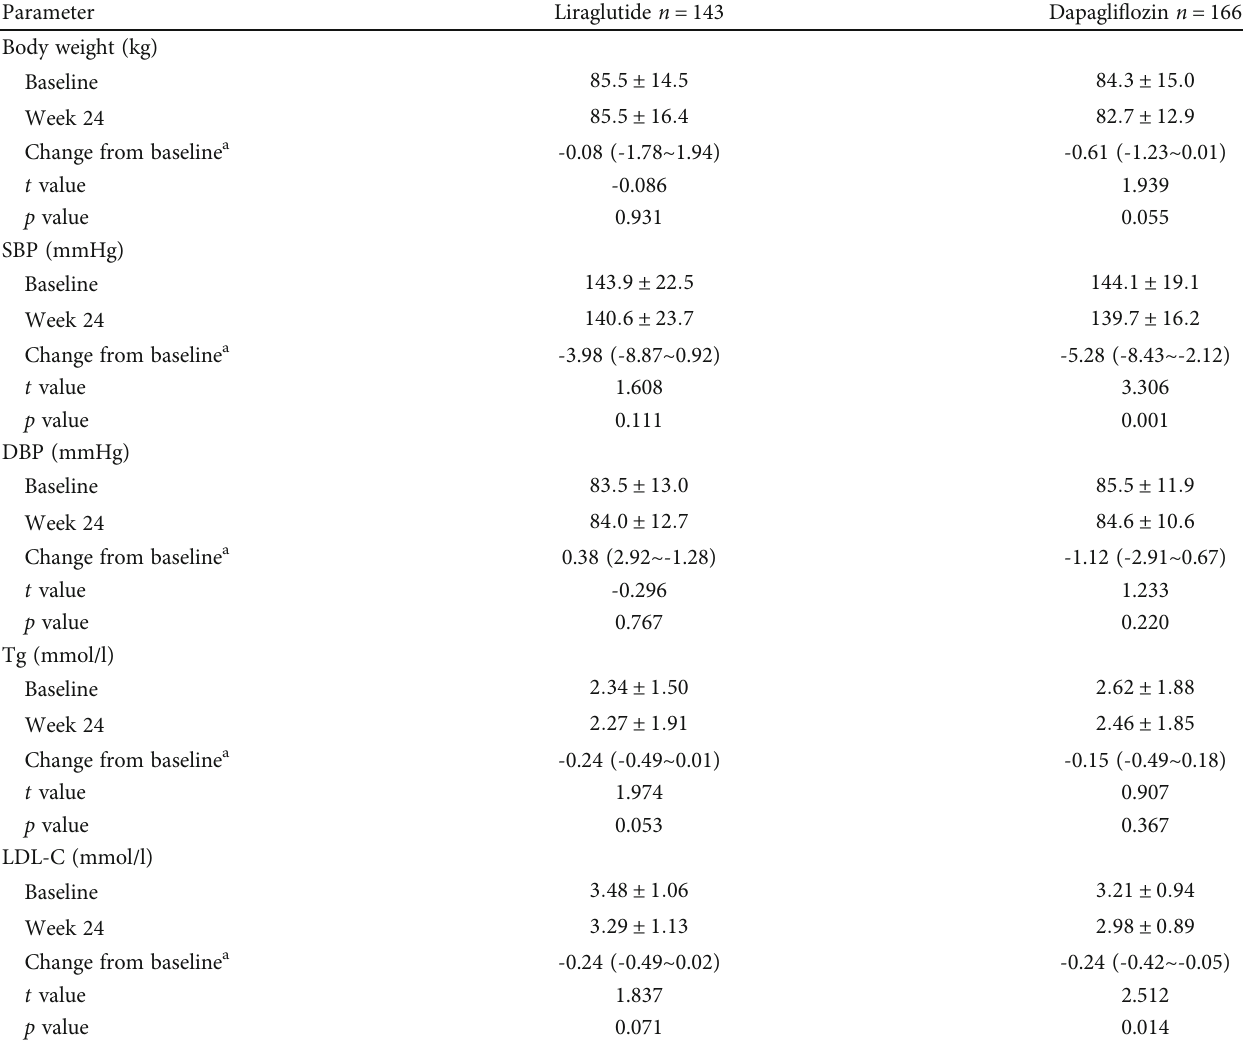
Table 3: Changes in other metabolic indicators (body weight, Tg, LDL-C, DBP, and SBP) at week